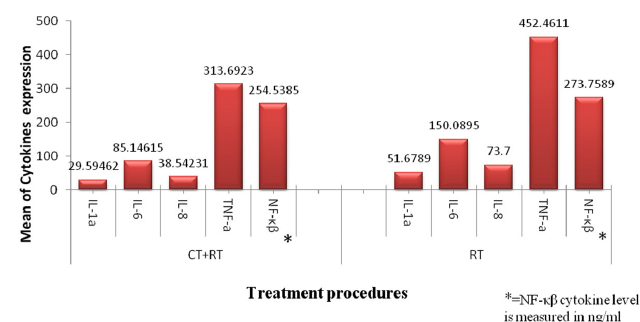
Fig. 2 - Graph depicting the mean of expression of different pro-inflammatory cytokines for patients undergoing radiation therapy along with chemotherapy (CT+RT) and those undergoing only the radiation therapy (RT).